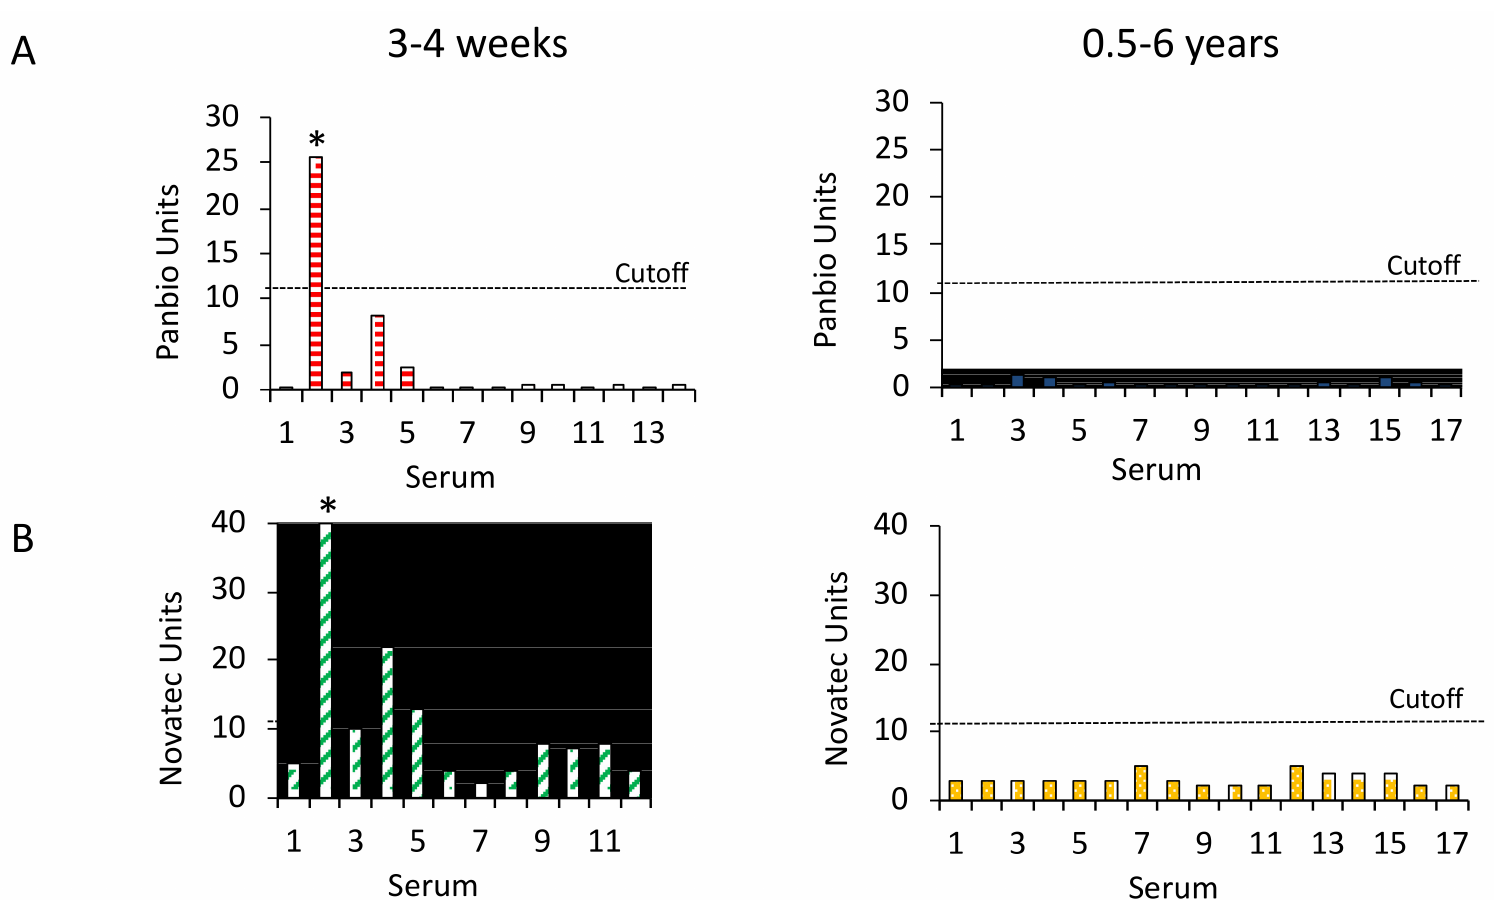
Figure 4. Panbio and NovaLisa Dengue IgG ELISA reactivity with sera from JEV-vaccinated individuals. ( A ) Panbio and ( B ) NovaLisa ELISA units with sera from 3–4 weeks (N = 14 and 12, respectively) and 0.5–6 years (N = 17) after JEV vaccination. The cut-off for positive sera is 11 assay units. Asterisks indicate the serum that neutralized